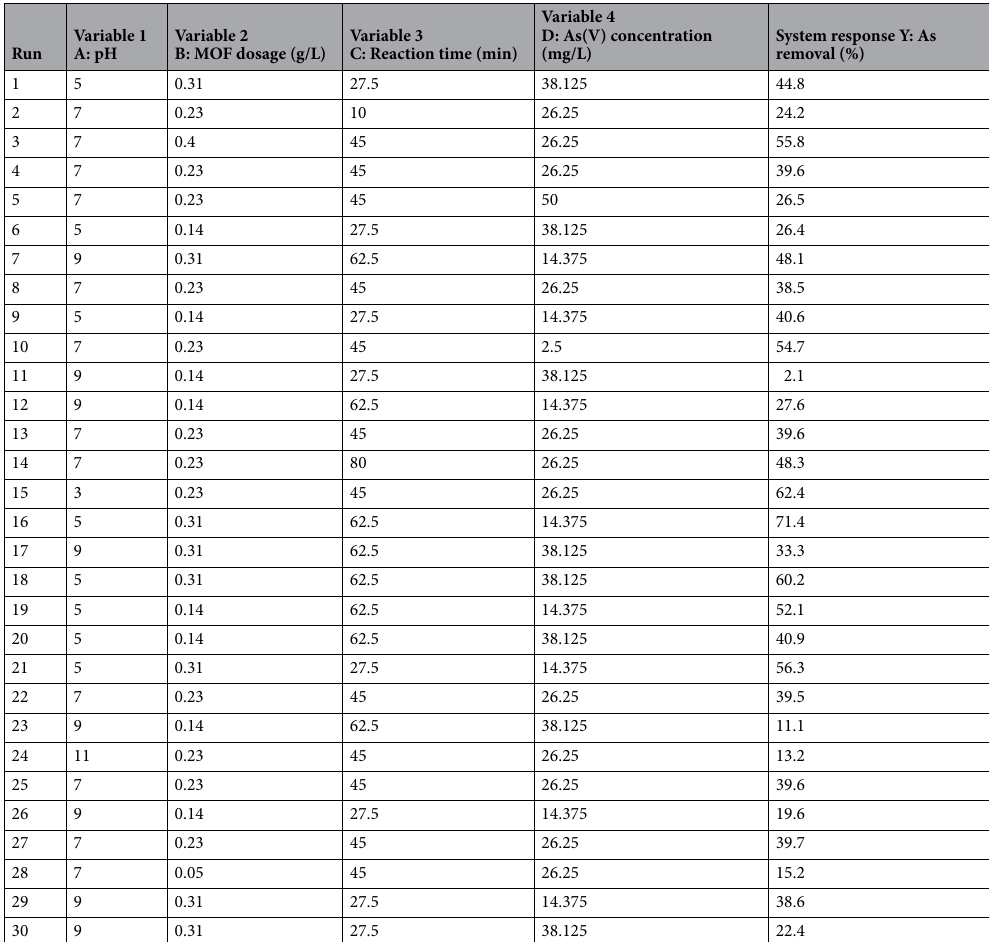
Table 2. Experimental design with As(V) removal